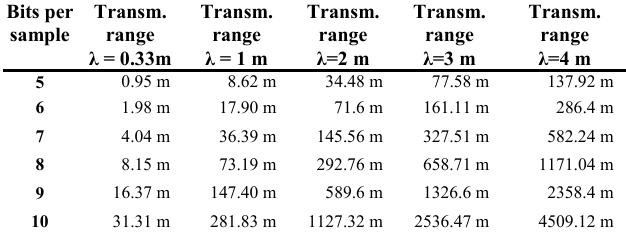
Table 4: The transmission range for different amount of λ